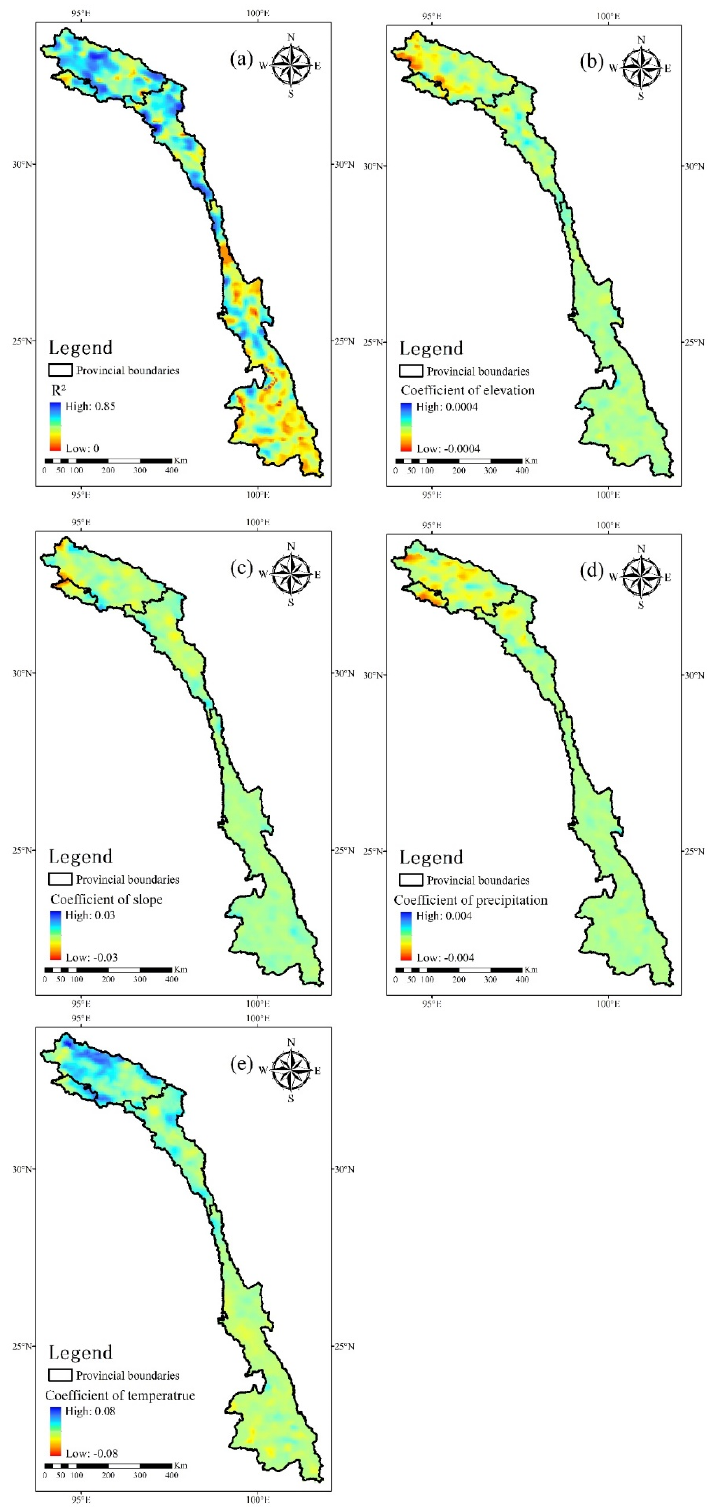
Figure 9. GWR results in the Lancang River Basin. ( a ) Local R2 of GWR, ( b ) coefficients of elevation, ( c ) coefficients of slope, ( d ) coefficients of precipitation, and ( e ) coefficients of temperature.